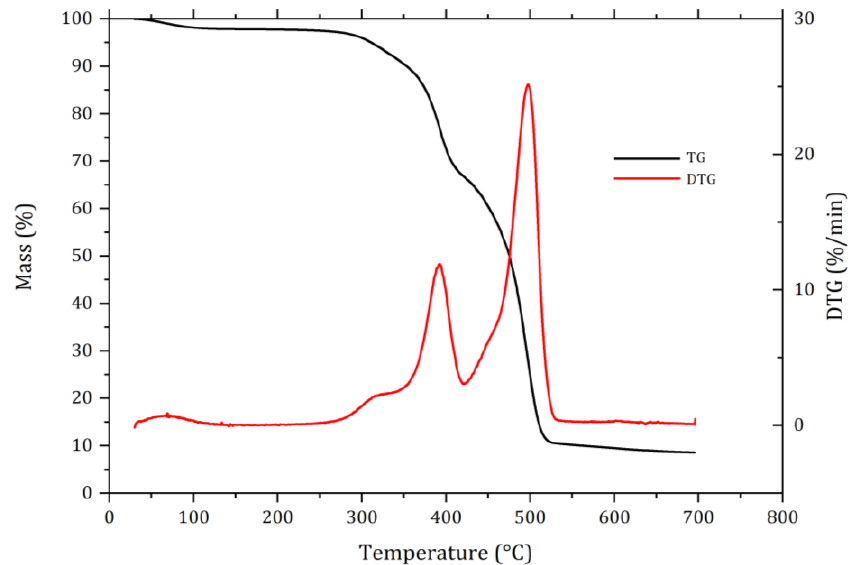
Figure 1. TGA curves of industrial waste (W). Reprinting with permission from ref. [16]. Copyright 2021 Elsevier.